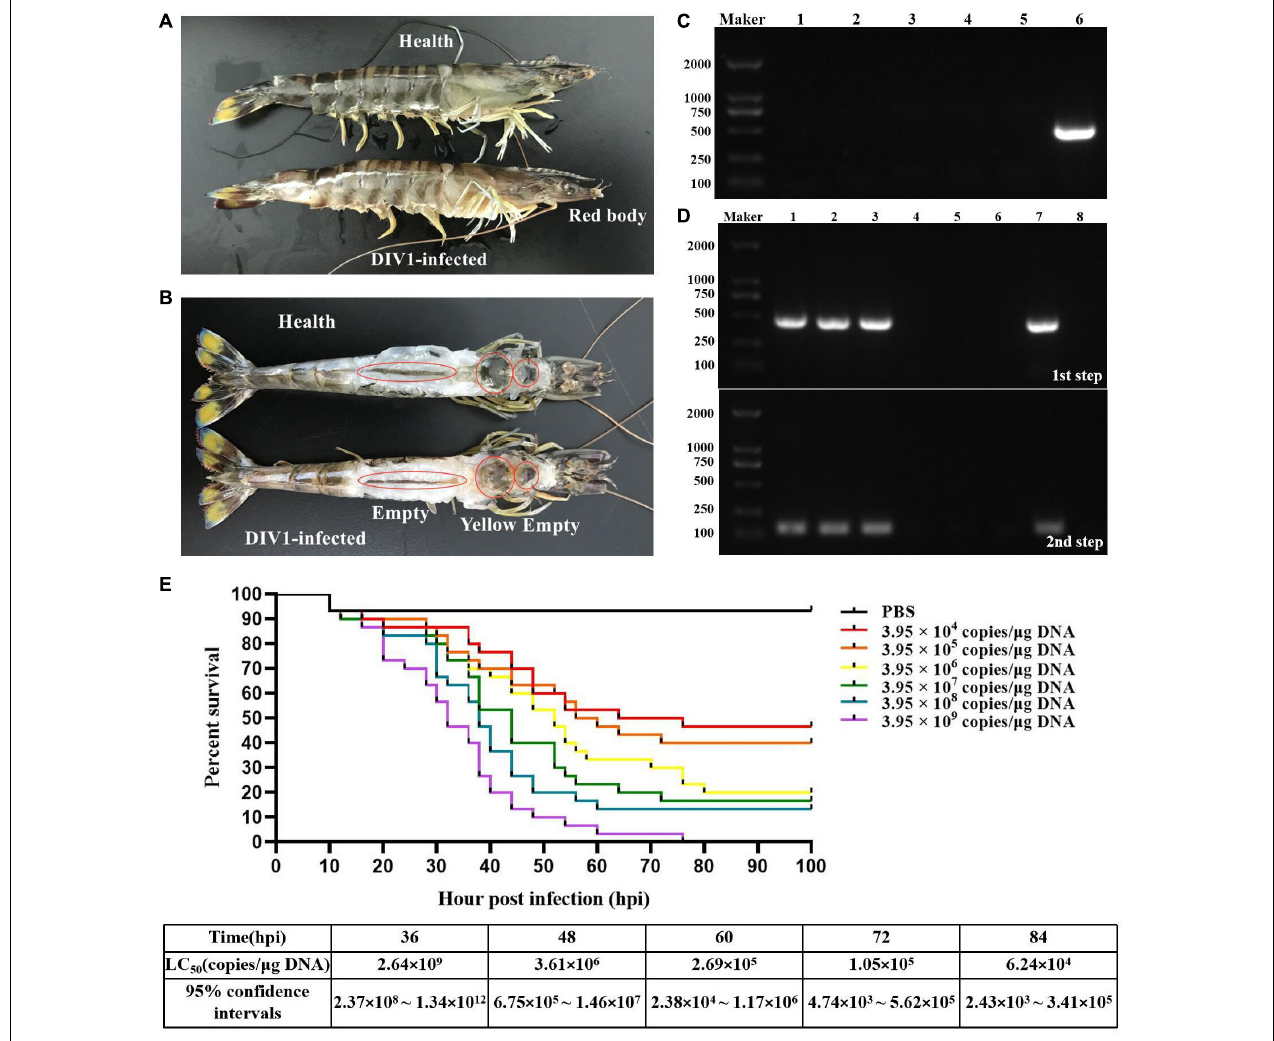
FIGURE 1 | Clinical symptoms and LC 50 test. (A,B) Clinical symptoms of DIV1-infected Marsupenaeus japonicus . (C) Virus detection of healthy M. japonicus and diseased shrimp used for LC 50 test. Marker, DL2000 molecular mass marker; lanes 1–3: PCR-amplified products used for WSSV, IHHNV, and DIV1 detection in healthy M. japonicus ; lanes 4–6, PCR-amplified products used for WSSV, IHHNV, and DIV1 detection in diseased shrimp. (D) DIV1 detection of M. japonicus hemocytes using nested PCR method. Marker: DL2000 molecular mass marker; lanes 1-3: PCR amplified products in DIV1-infected group; lanes 4-6: PCR amplified products in negative control group; lanes 7 and 8: PCR amplified products in positive and negative controls. (E) Seven groups of healthy M. japonicus were intramuscularly injected with 50 µ l of DIV1 inoculum at six concentrations and phosphate-buffered saline as a